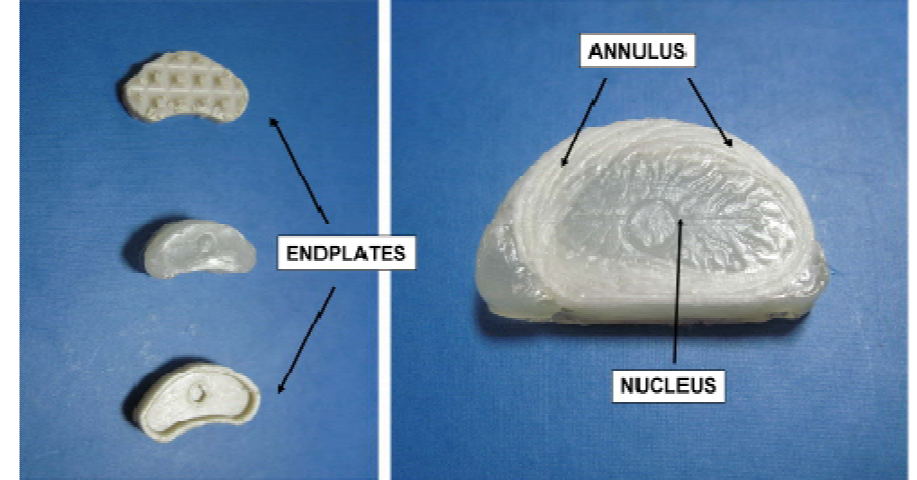
Figure 2. A multicomponent fiber-reinforced, poly(2-hydroxyethylmethacrylate) (PHEMA)-based Hydrogel/hydroxyapatite-reinforced polyethylene composite (HAPEX TM ) device for customized intervertebral disc